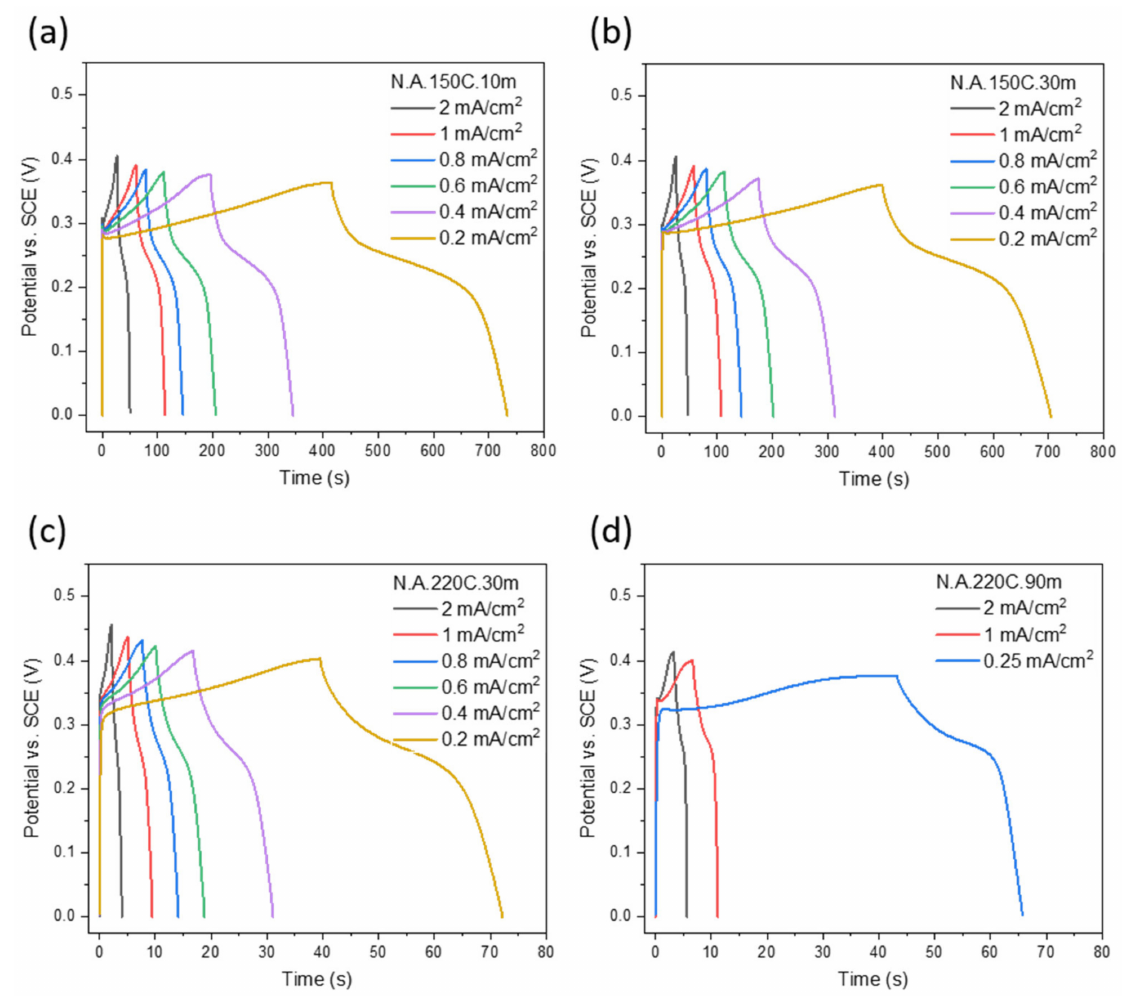
Figure 6. GCD curves of ( a ) N.A.150C.10m, ( b ) N.A.150C.30m, ( c ) N.A.220C.30m, and ( d ) N.A.220C.90m electrodes on SS at different current densities in KOH electrolyte. For the same reason, the GCD curves at 1 mA/cm 2 in Figure 7a clarify the discharg- ing times of the N.A.150C.10m and N.A.150C.30m electrodes are considerably extended compared to the N.A.220C.30m and N.A.220C.90m electrodes. It is important to remember that the discharge time is directly proportional to the areal capacity. On the one hand, the maximum areal capacities at 0.2 mA/cm 2 are calculated as 17.7 and 17.0 µ Ah/cm 2 for the N.A.150C.10m and N.A.150C.30m electrodes, respectively, significantly exceeded 1.8 and 1.6 µ Ah/cm 2 for the N.A.220C.30m and N.A.220C.90m electrodes, respectively. On